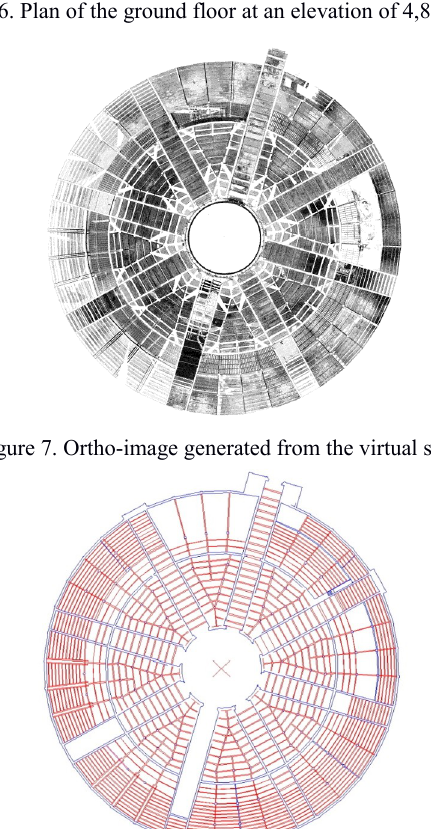
Figure 5. Perspectives of the model with the view of the internal spaces (lateral view, view from above and inclined view).